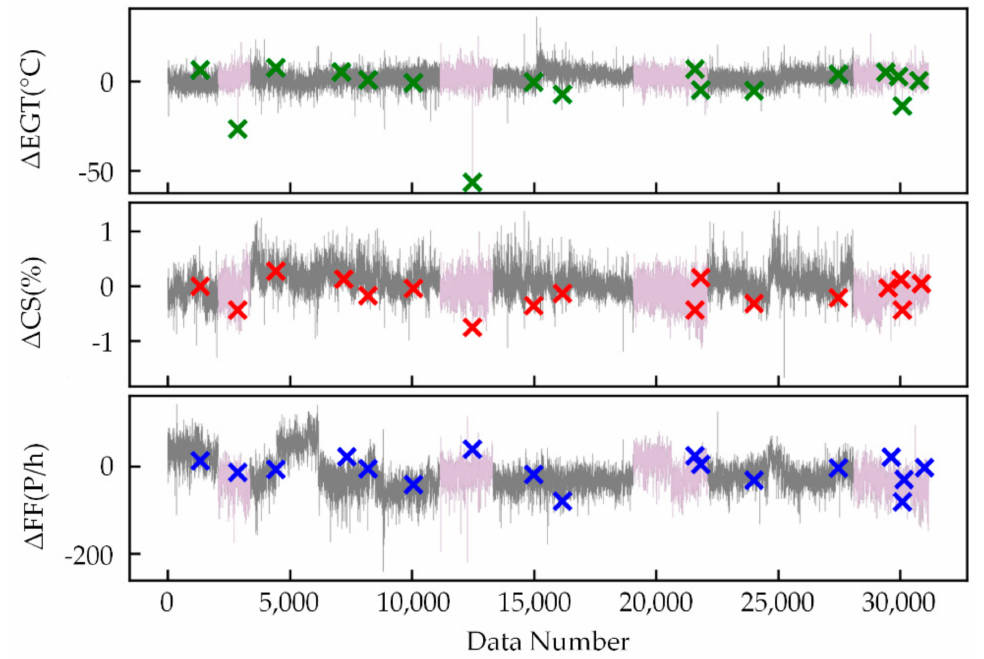
Figure 11. Extracted features trained with old engine